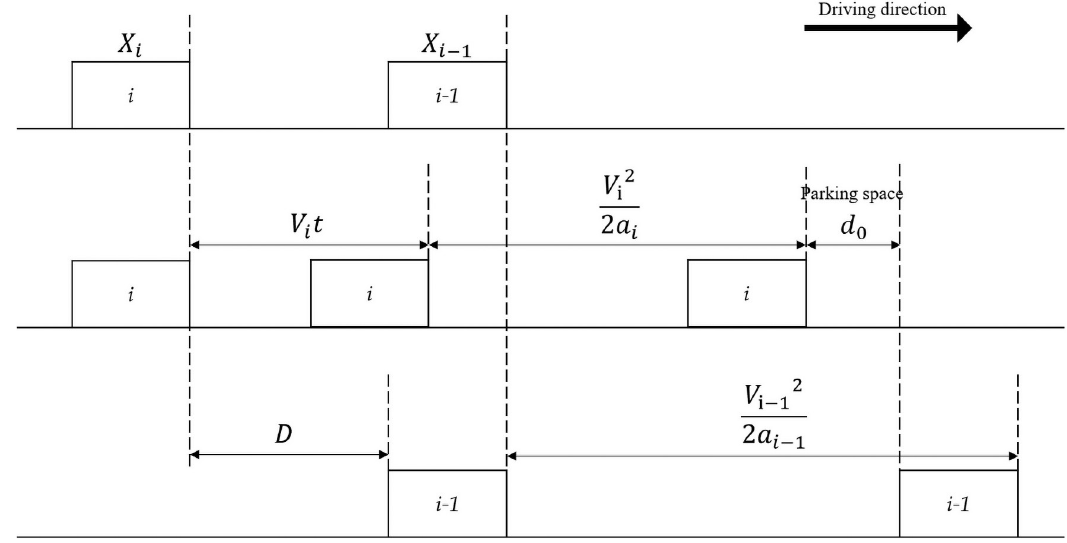
Fig 2. Vehicle braking